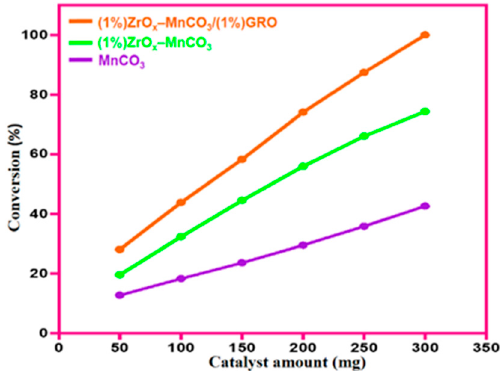
Figure 10. Impact of the quantity of the as-prepared catalysts on the catalytic properties. Under optimal circumstances, a blank reaction was conducted over